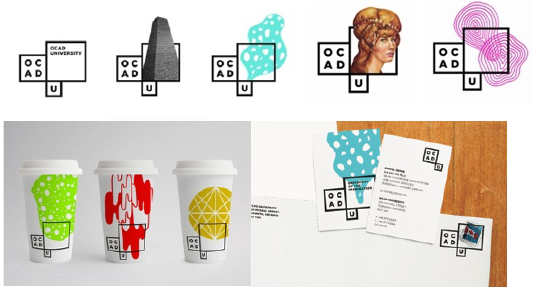
Fig. 4. Examples of logos and applications of the OCAD University